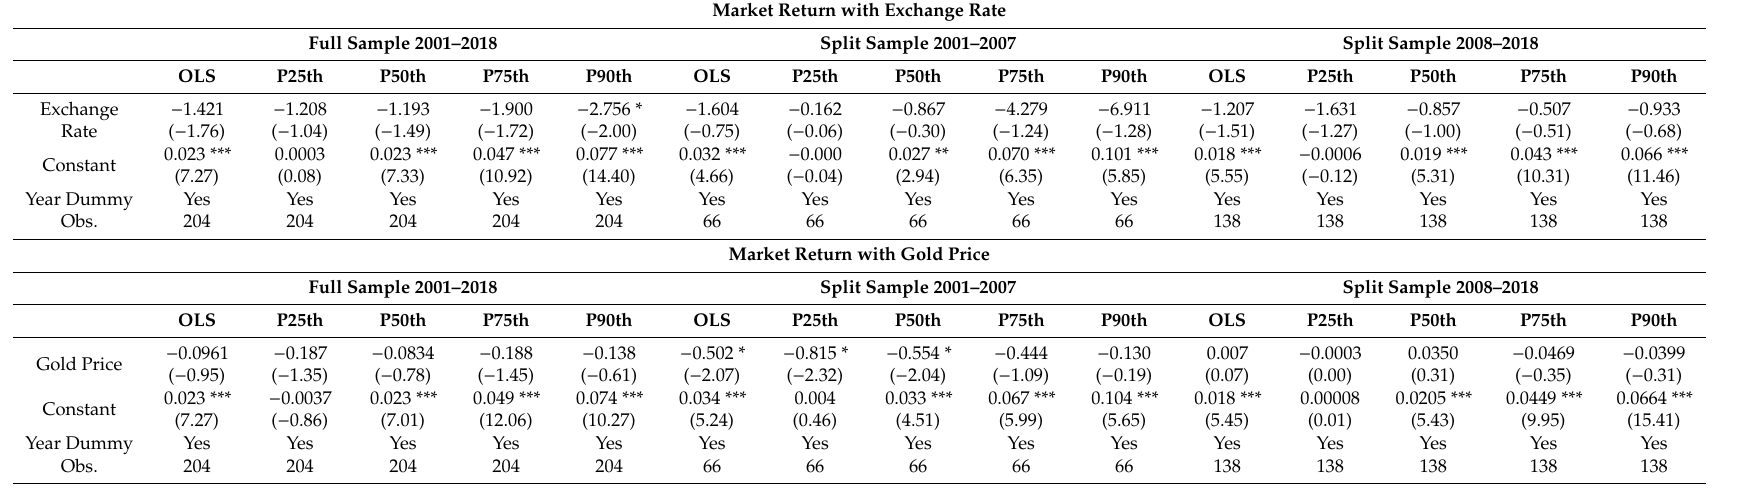
Table 6. Regression results